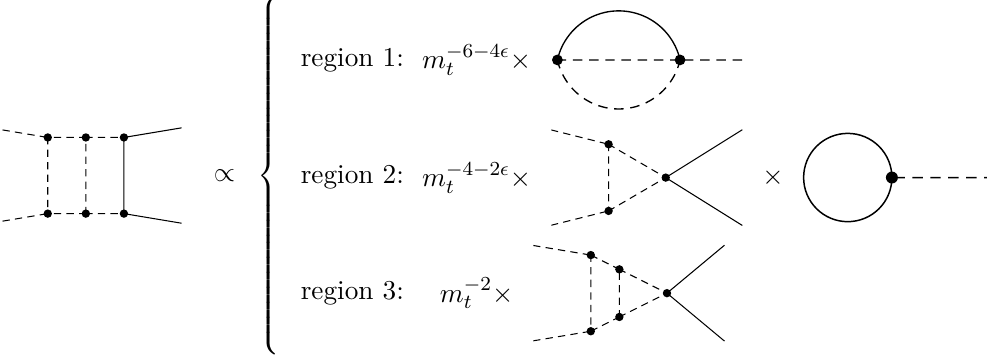
Figure 5. A typical master integral and its leading regions. Solid and dashed lines correspond to massive and massless particles respectively. Internal massive particles have mass m t , while external massive particles have mass m W